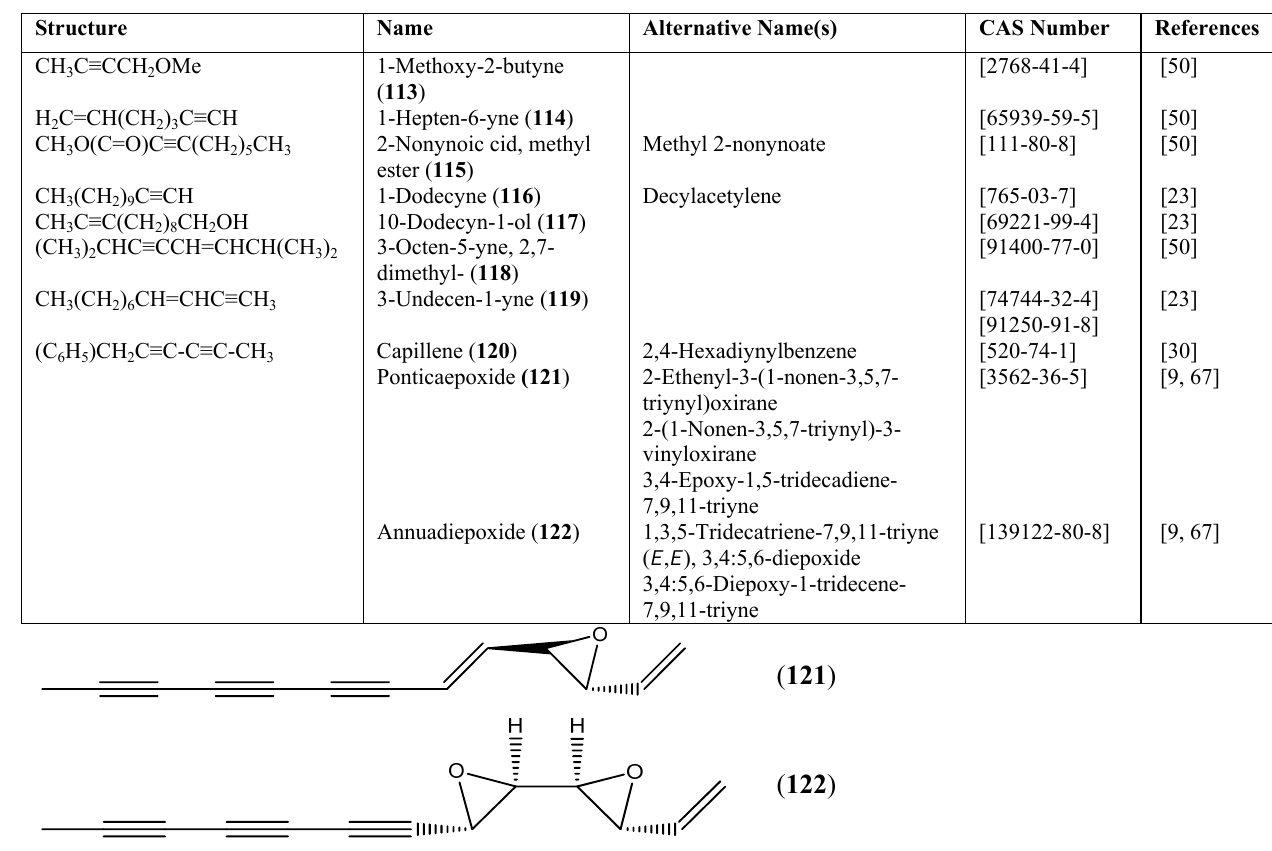
Table 9. Acetylenic